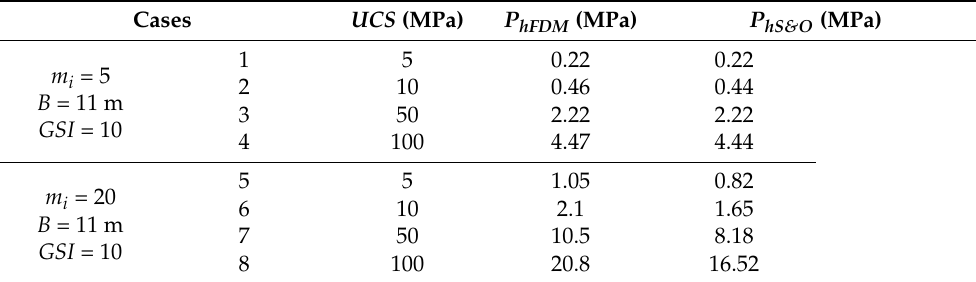
Table 2. Results of P hFDM and P hS&O for different case studies.